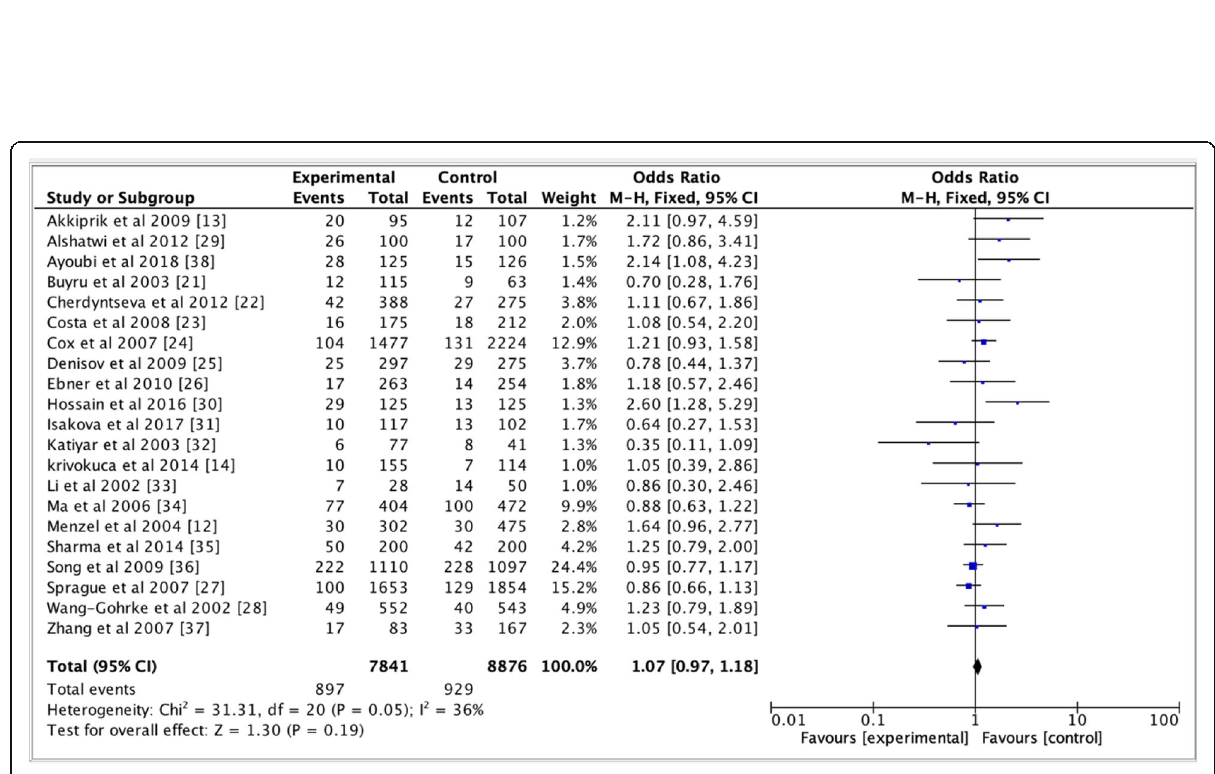
Fig. 3 Forest plots of the association between breast cancer and TP53 p.Arg72Pro polymorphism for the recessive model. The black diamond denotes the pooled OR; blue squares indicate the OR in each study with square sizes inversely proportional to the standard error of the OR; and horizontal lines represent the 95%